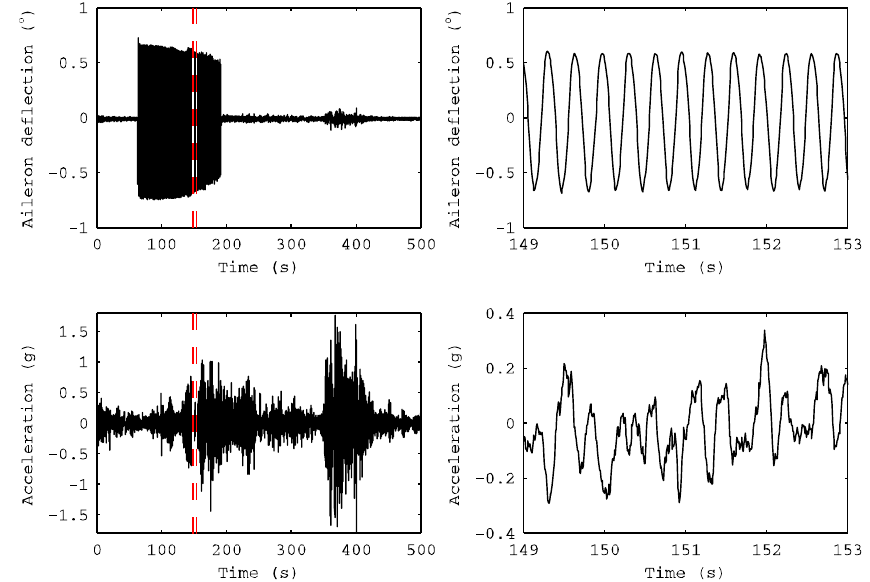
Fig. 9. Measurement of aileron deflection (top) and response acceleration at the wing (bottom), full measurement record processed (left) and detail (right).